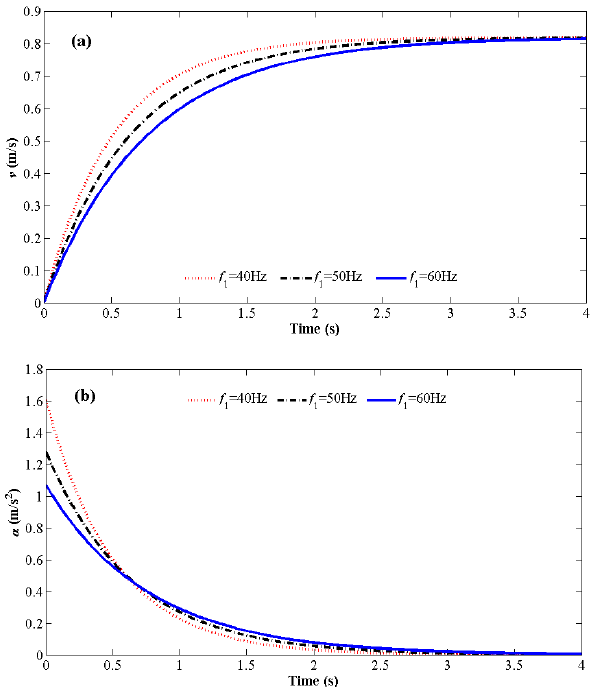
Figure 6. Velocity (a) and acceleration (b) characteristics of the MDFMS under varied power frequencies.